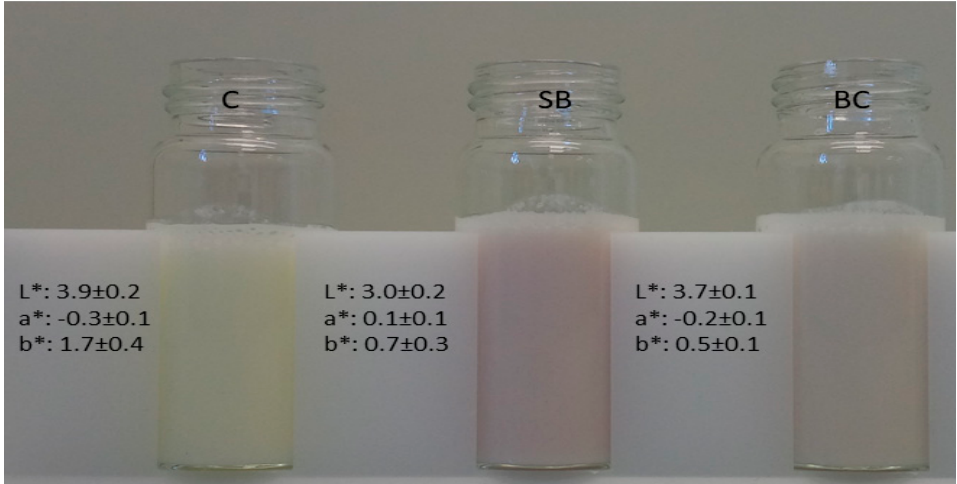
Figure 4. Color properties of yogurt beverages. Numerical findings represent color differences between samples using the CIE L*a*b* (International Commission on Illumination) color scale ± SD.